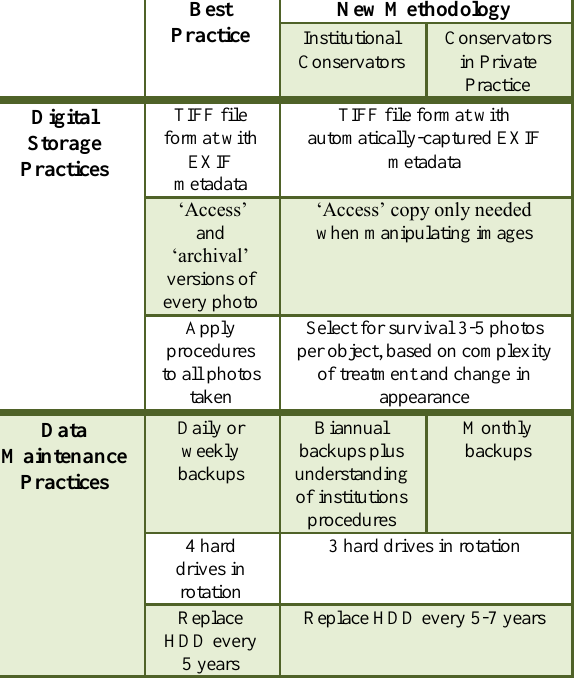
Figure 3. Table showing the previous best practice recommendations in comparison with the recommendations of the new methodology, for both institutional and private practice